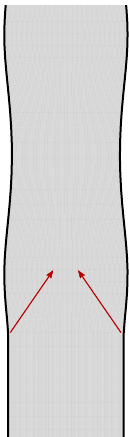
Figure 5 . A 2-sided kick to the eternal traversable wormhole. Originally, the distance between the two sides is constant. The perturbation causes the boundaries to oscillate. This should be compared with (cid:12)gure 3, where the complexity also oscillates after a perturbation. the complexity of formation. Since the Euclidean preparation of the state uses a strip of length (cid:24) (cid:12) (and not log (cid:12) ), we view this formula as evidence that the microscopic de(cid:12)nition of complexity must distinguish between Euclidean and Lorentzian (unitary)